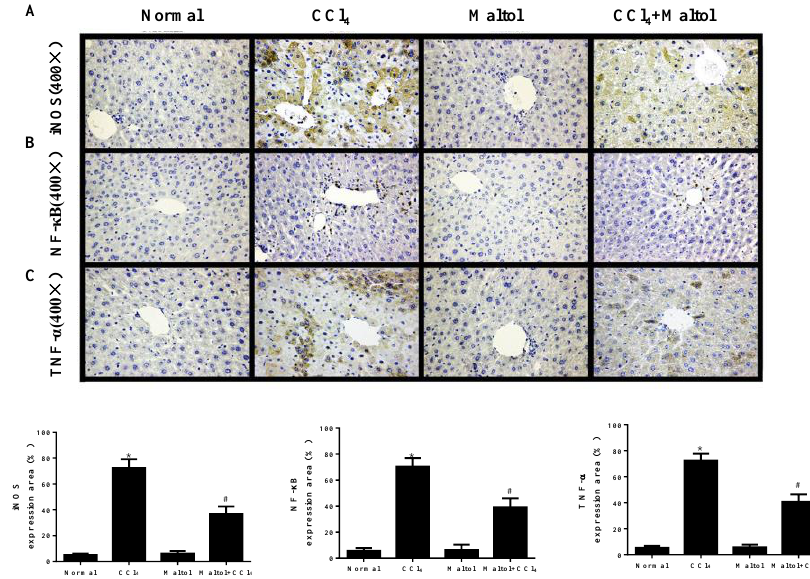
Figure 7. Effects of maltol on the CCl 4 -induced expression of inflammatory mediators: photomicrographs of ( A ): iNOS (1:100), ( B ): NF- κ B (1:100), ( C ): TNF- α (1:100) at 400 × . From histopathological staining analysis, in normal livers, the serum levels of cytokines expression were negligible, with the CCl 4 group having a lot of positive staining. The livers of mice receiving CCl 4 + maltol were similar to controls. The brown spots showed positive. iNOS, inducible nitric oxide synthase; NF- κ B, nuclear factor-kappa B; TNF- α , Tumor necrosis factor- α ; IL-1 β , interleukin-1 β . Values are expressed as the mean ± S.D., n = 8. * p < 0.05 vs. normal group; # p < 0.05 vs. CCl 4